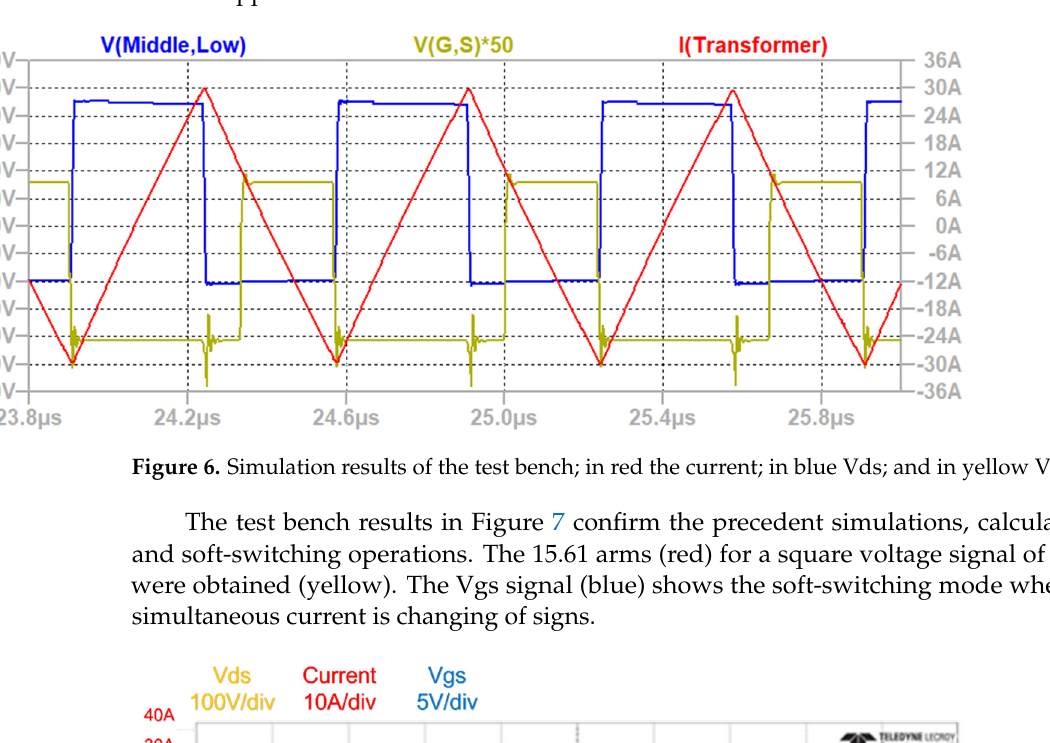
( b ) Figure 8. Open-circuit test: ( a ) Studied lines of magnetic field; ( b ) Magnetic field.